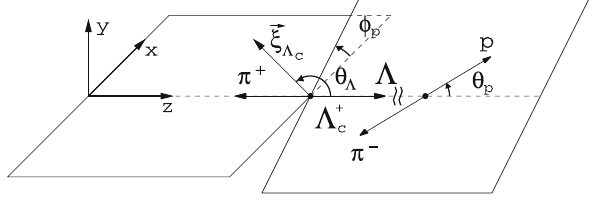
Fig. 9 Definitionofanglesinthepolarised Λ + c decay Λ + c → Λπ +